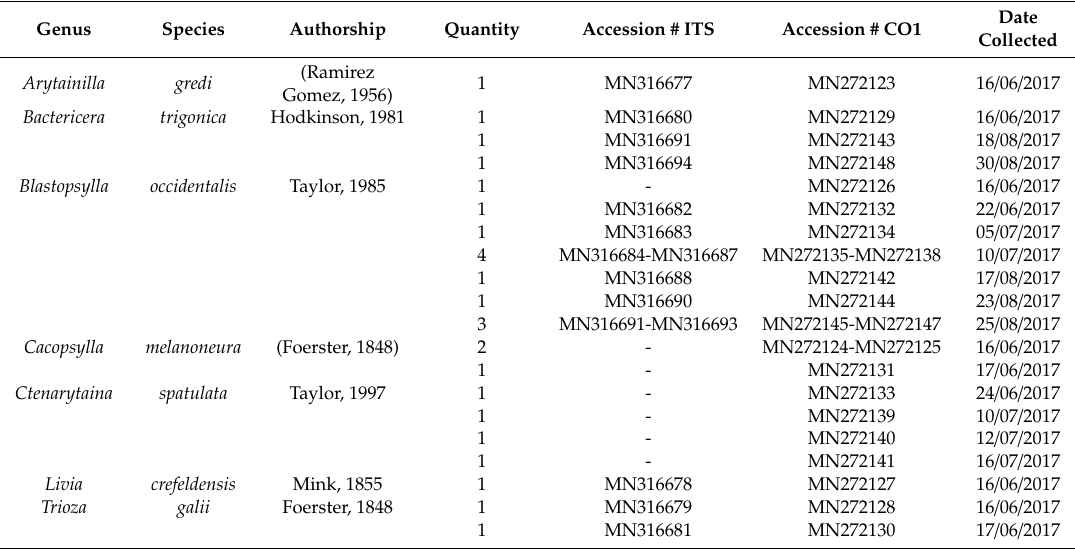
Table 5. Psyllid species collected by the suction trap in the potato field in Aldearrubia Salamanca. CO1 gene regions were successfully sequenced from all psyllid specimens. Internal transcribed region 2 (ITS2) sequencing was successful for all except the C. melanoneura and Ct. spatulata specimens. Genus Species